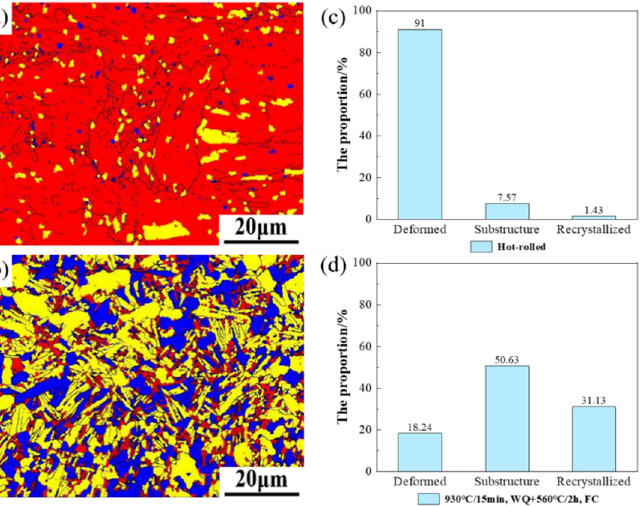
Figure 11. Recrystallized (blue), substructure (yellow), and deformed (red) grains in TC4 alloy: ( a ) and ( c ) Hot-rolled; ( b ) and ( d ) 930 °C/15 min, WQ + 560 °C/2 h, FC. ( a , c ) Hot-rolled; ( b , d ) 930 ◦ C/15 min, WQ + 560 ◦ C/2 h,